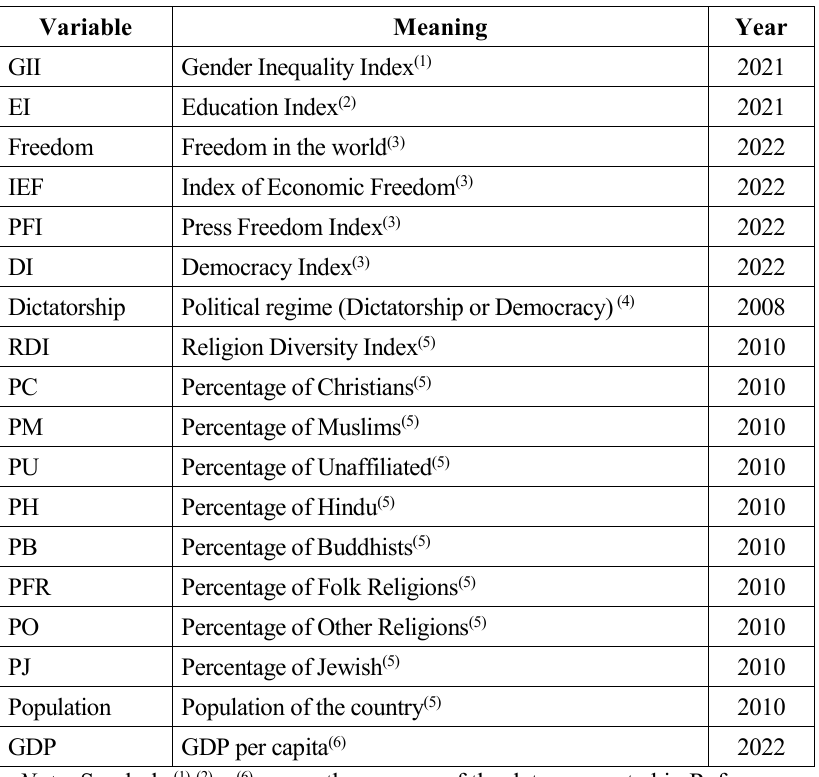
Table 1. Description of